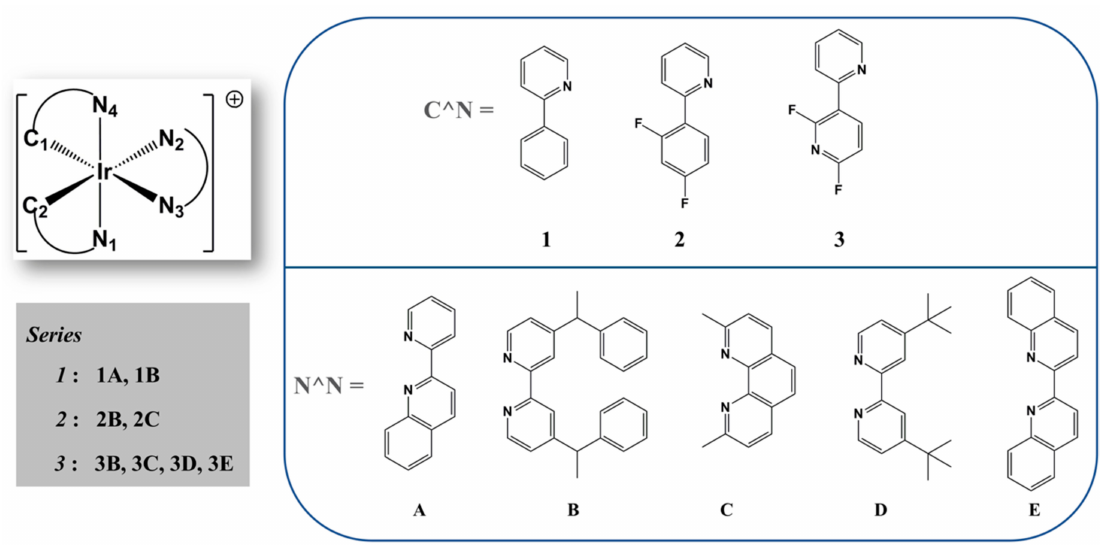
Figure 1. Molecular structures of the Ir(III) complexes studied. Labeling of the atoms coordinated with the metallic center is included to guide the description of the geometric